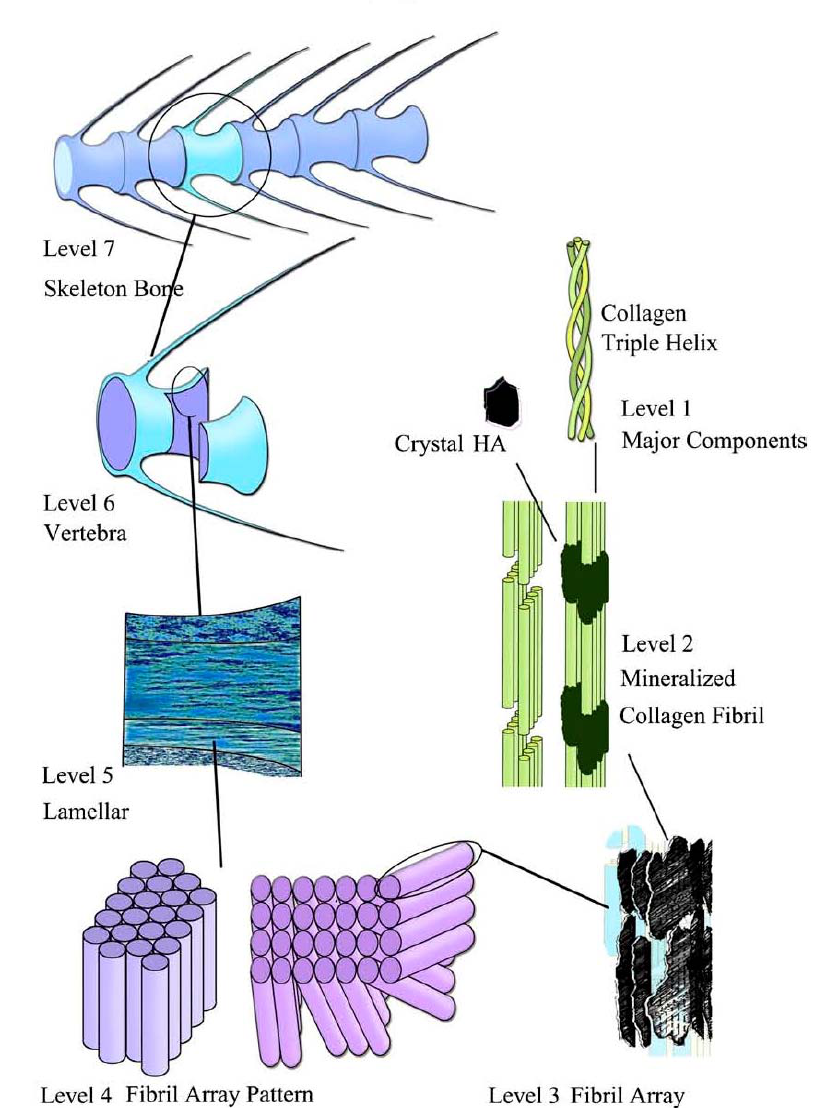
Figure 7. The seven hierarchical levels of organization of the zebrafish skeleton bone. Level 1: Isolated crystals and part of a collagen fibril with the triple helix structure. Level 2: Mineralized collagen fibrils. Level 3: The array of mineralized collagen fibrils with a cross-striation periodicity of nearly 60-70 nm. Level 4: Two fibril array patterns of organization as found in the zebrafish skeleton bone. Level 5: The lamellar structure in one vertebra. Level 6: A vertebra. Level 7: Skeleton bone. Reprinted from Ref. [418] with permission. Other good graphical sketches of the hierarchical structure of bones are available in Refs.